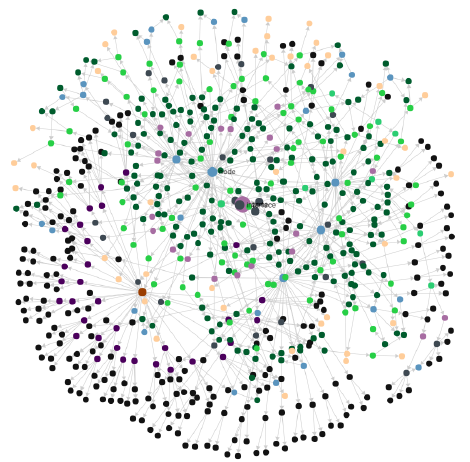
Figure 8. Collected data as a graph. Each vertex represents one common language element. The colors show different common language